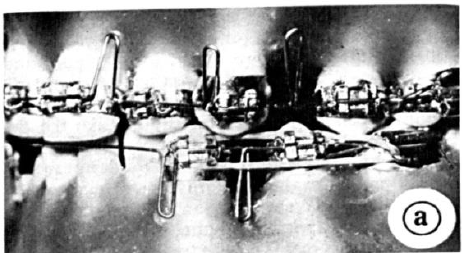
Figure 1: Canine retraction using full archwire without bonding the lower